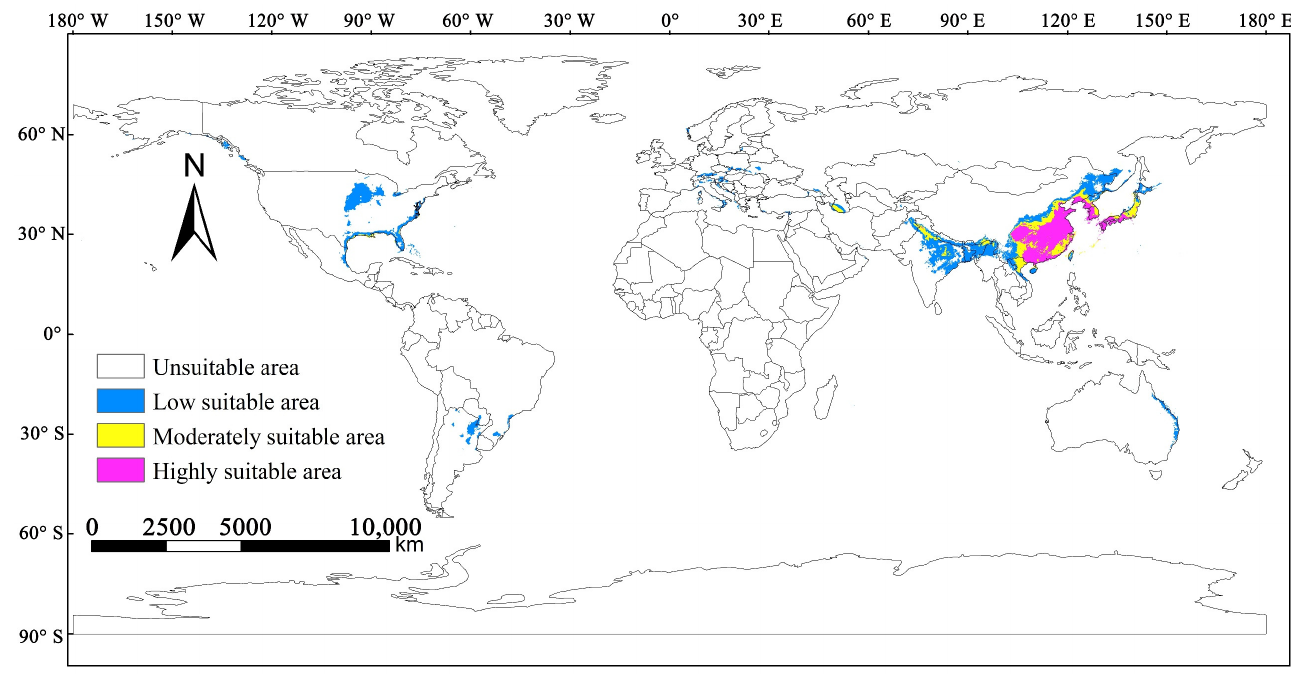
Figure 3. Potential suitable distribution areas of M. alternatus at global scale under current climate conditions.